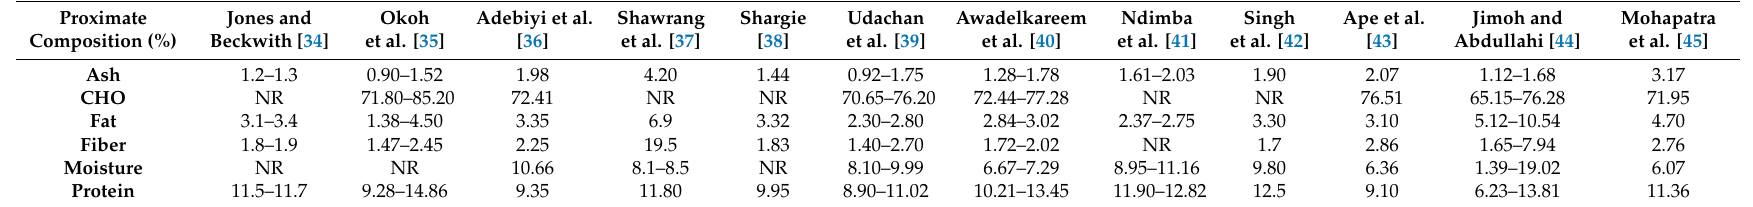
Table 1. Proximate composition of